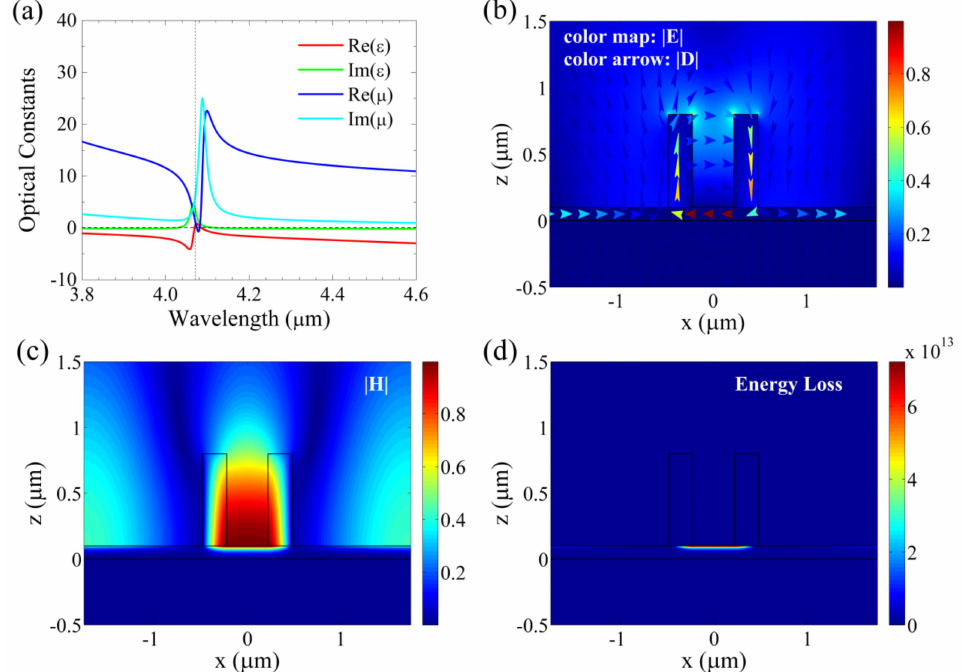
Figure 3. ( a ) Retrieved optical constants for the designed narrowband PA. ( b ) Electric field (map) and displacement current (arrow) distributions. ( c ) Magnetic field distribution. ( d ) Energy dissipation (in W / m 3 ). Note that the vertical dashed line in ( a ) and the profiles in ( b – d ) are at λ = 4.071 µ m. The electromagnetic field and displacement current distributions in ( b , c ) are self-normalized, respectively. The color of the arrows in ( b ) represents the intensity of the displacement